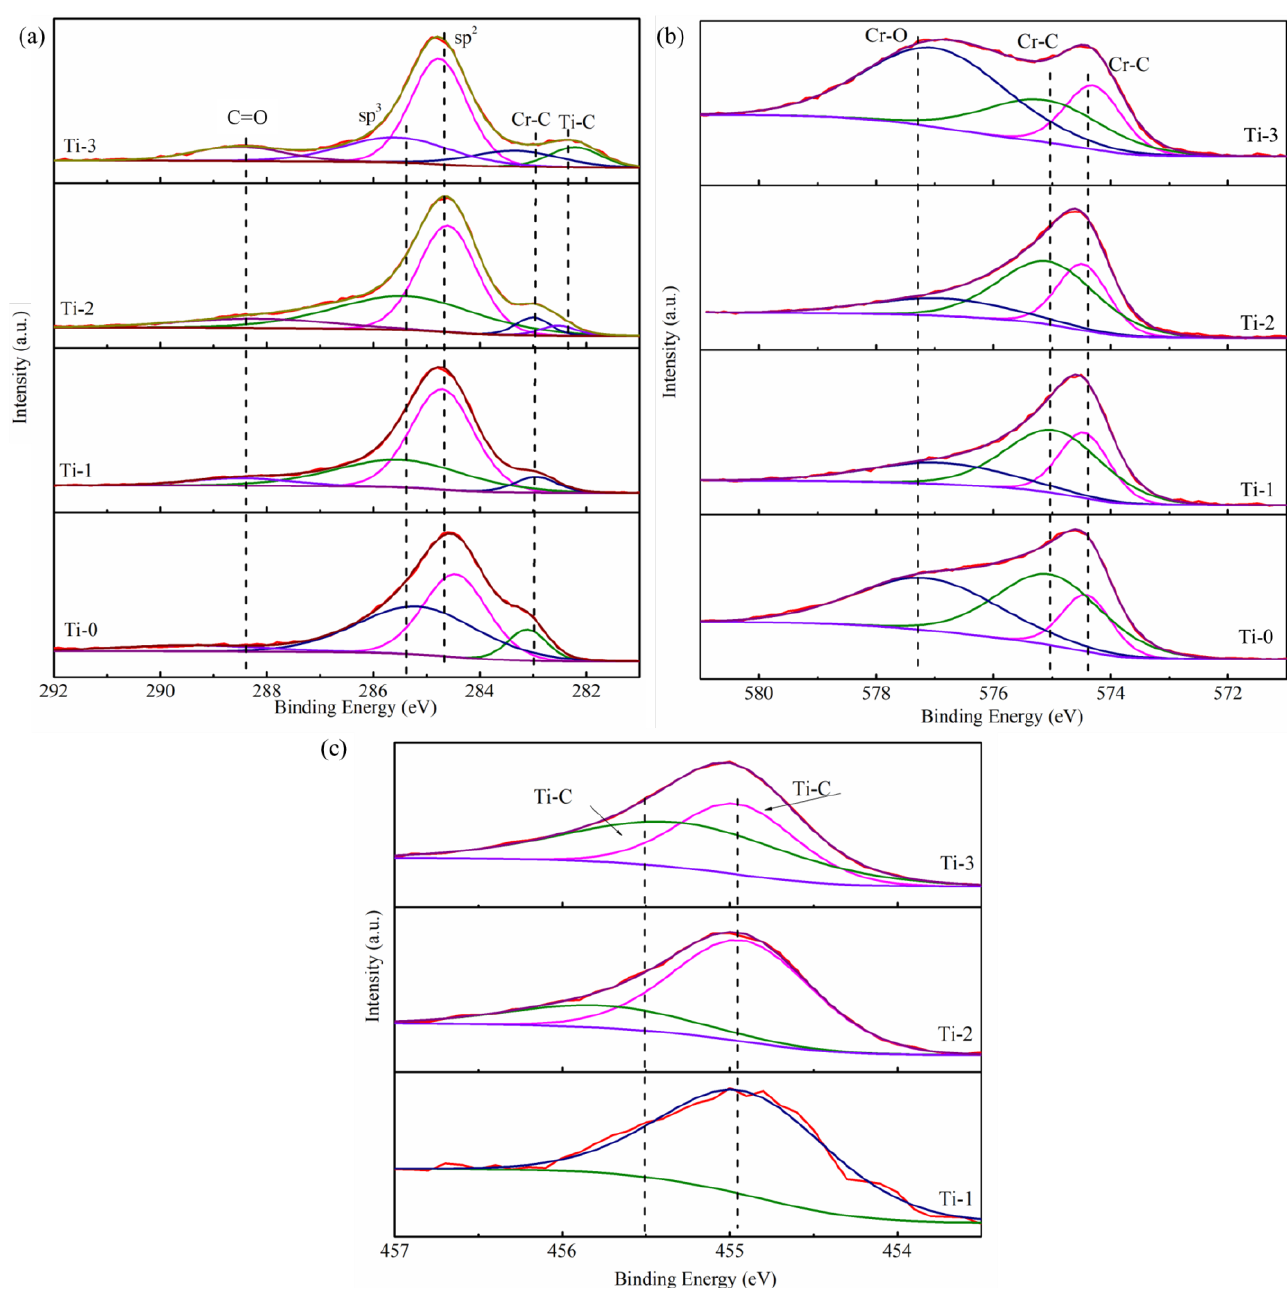
Figure 9. XPS patterns of the amorphous carbon films after +1.1 V (vs. SHE) corrosion, ( a ) C1s, ( b ) Cr 2p, ( c ) Ti 2p.